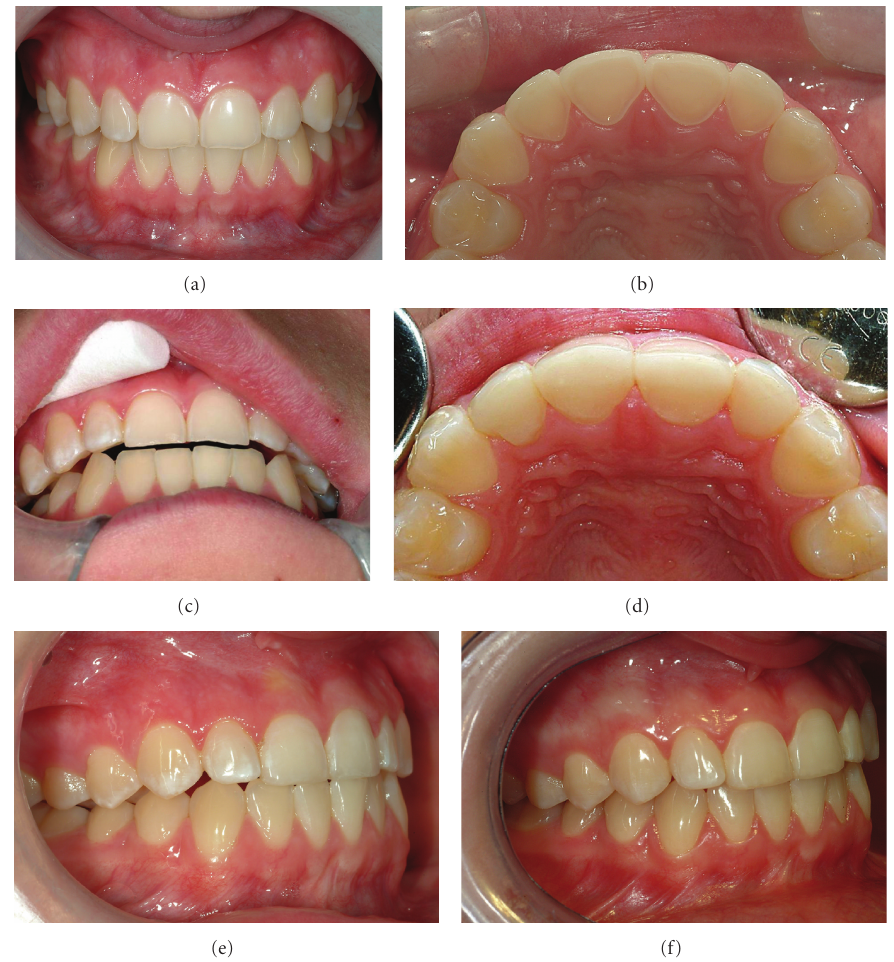
Figure 11: (a) A 15-year-old girl with dental erosion confined mainly to maxillary anterior teeth caused by excessive soft drink consumption. (b) Substantial loss of toots substance palatally on teeth nos. 12–22 with shoulder formation. (c) Vertical dimension established by composite restoration on 12 allowing adequate space for restorative material. (d) Coverage with composite on teeth nos. 13–23. (e) Just after placement of composite. Note the nonoccluding posterior teeth. (f) After a short period of time, reestablishment of the posterior occlusion utilizing the Dahl principle